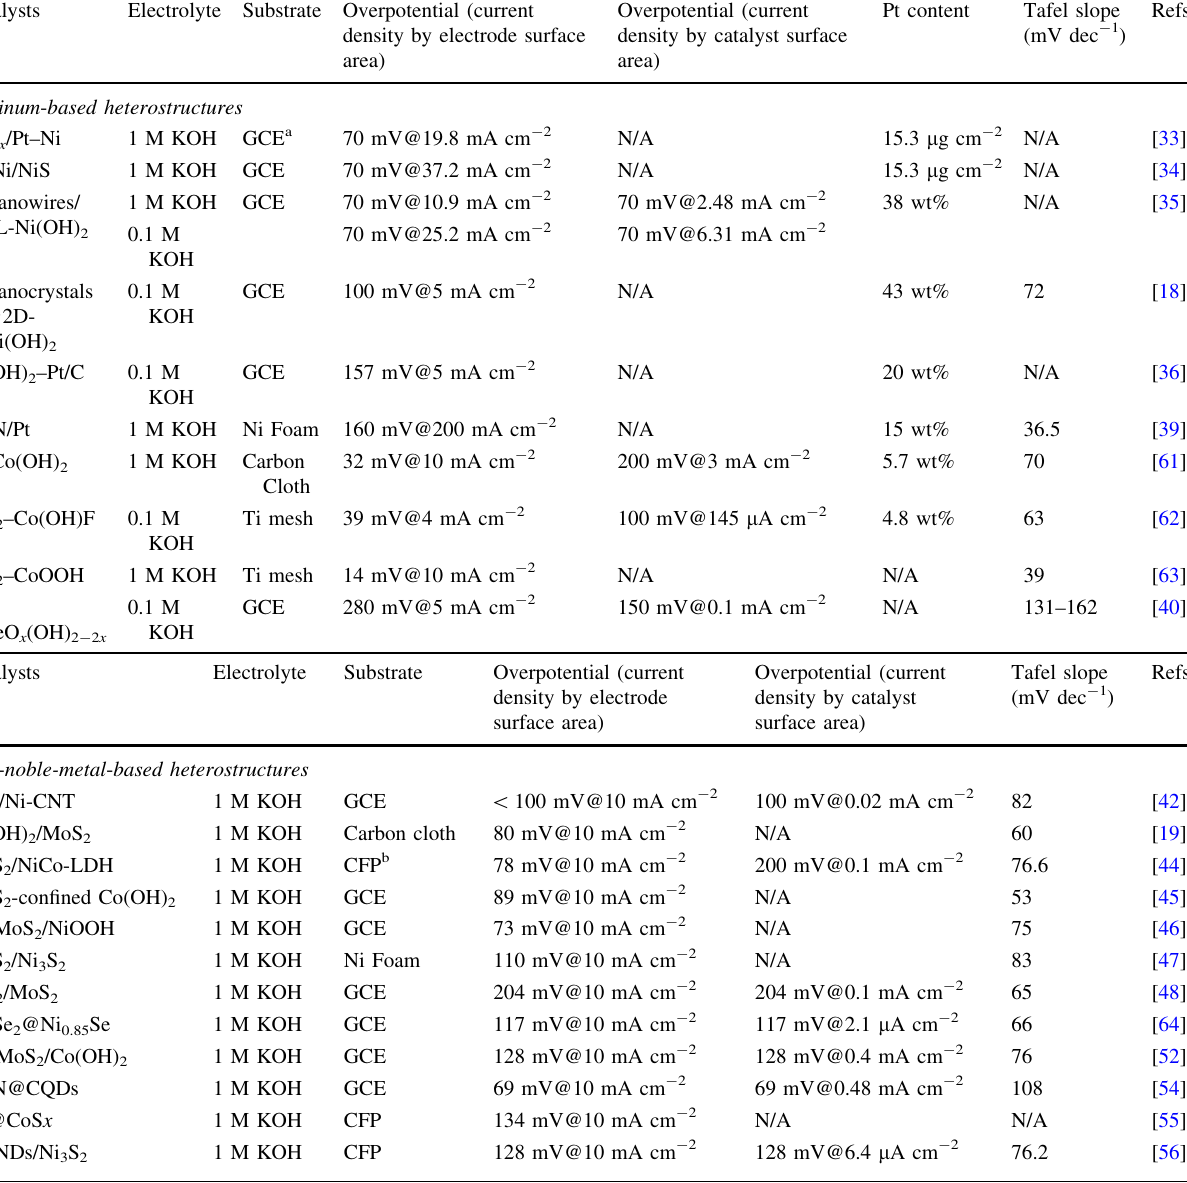
Table 1 Performance of reported heterostructured catalysts for HER in alkaline medium Catalysts Electrolyte Substrate Overpotential (current